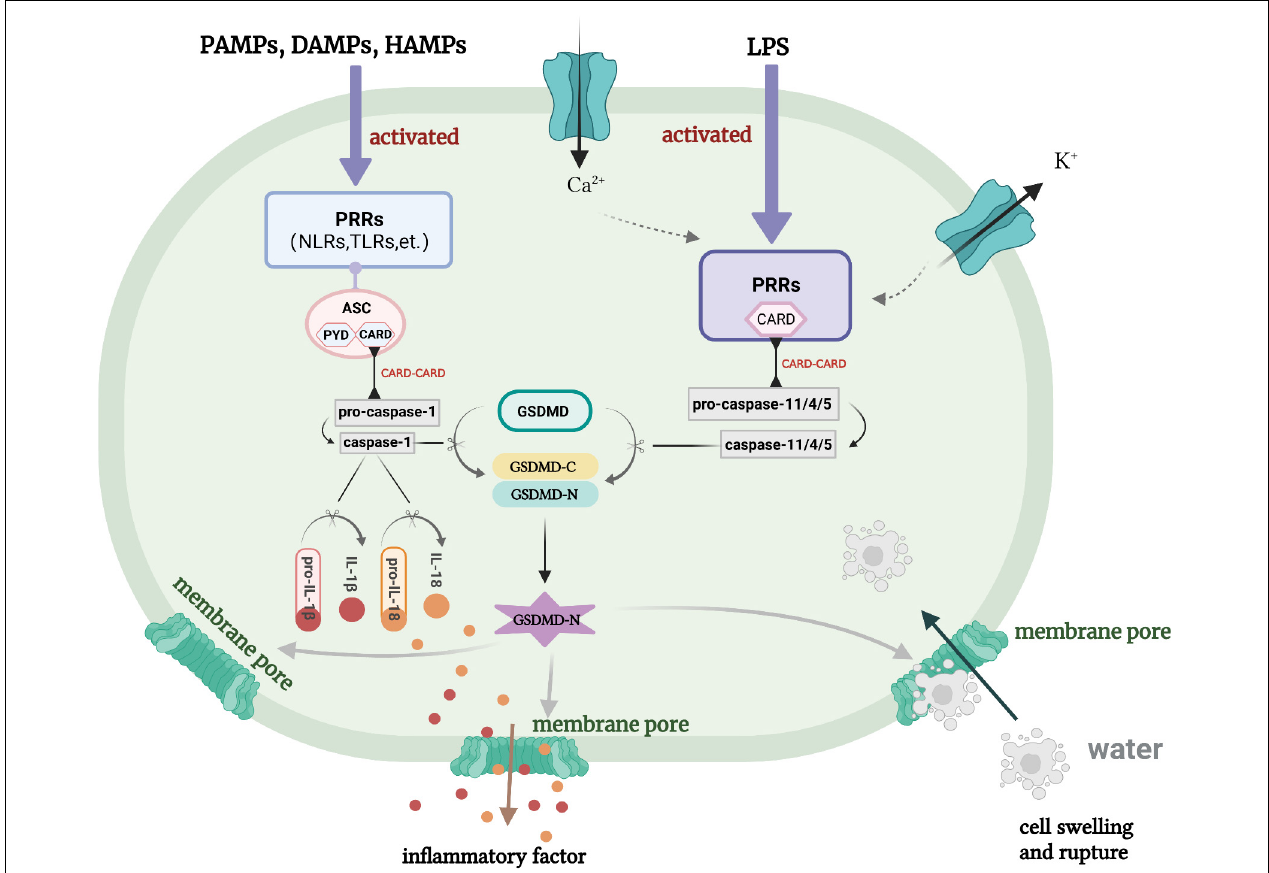
FIGURE 1 | Classical pathway and non-classical pathway of pyroptosis. PRRs, pattern recognition receptors; ASC, apoptosis-associated speck-like protein containing a caspase-recruitment domain; LPS, lipopolysaccharide; NLRS, nucleotide-binding oligomerization domain-like receptors; PAMPS, pathogen-associated molecular patterns; DAMPS, danger-associated molecular patterns; HAMPS, homeostasis-altering molecular